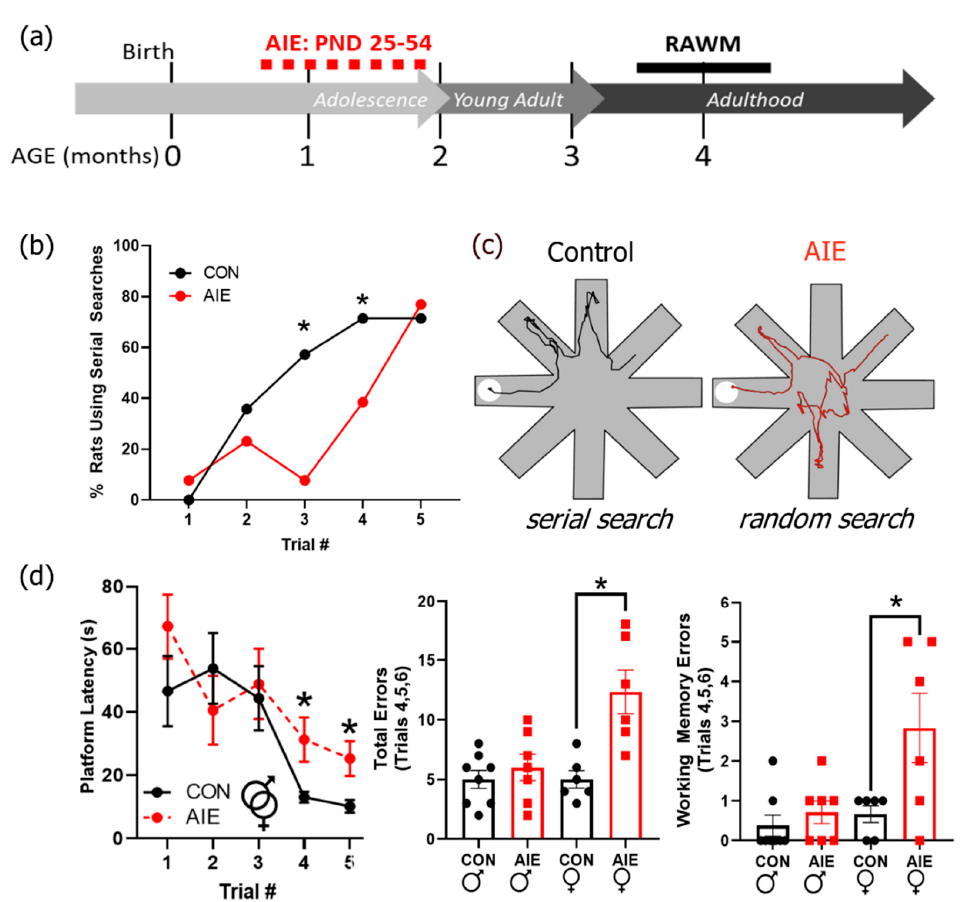
Figure 3. Adolescent intermittent ethanol (AIE) impairs problem-solving flexibility in the radial arm water maze (RAWM). ( a ) Timeline of RAWM paradigm. Rats underwent AIE or control gavage paradigms from PND 25–54. The RAWM was conducted later in adulthood (around 4 months of age). ( b ) Serial versus random search strategies were determined by a blind observer, as described in the methods. Controls increased employment of serial search strategies immediately after the first trial and increasingly employed serial searches on subsequent trials. AIE rats predominantly used random search strategies until trial three (males) and trial four (females), suggesting deficits in problem-solving strategy flexibility. ( c ) On the left is an example of typical run from a control rat using a serial search strategy (trial 5). On the right is an example run from an AIE rat using a random search strategy (trial 5). ( d ) AIE rats took longer to find the platform on the fourth and fifth runs of the first test day, suggesting a mild deficit in spatial learning. This effect is predominantly driven by an increase in the number of total errors made by AIE females. In addition, females tended to make more reference errors, suggesting deficits in working memory may be contributing to these results. Results are expressed as mean ± SEM. * p <